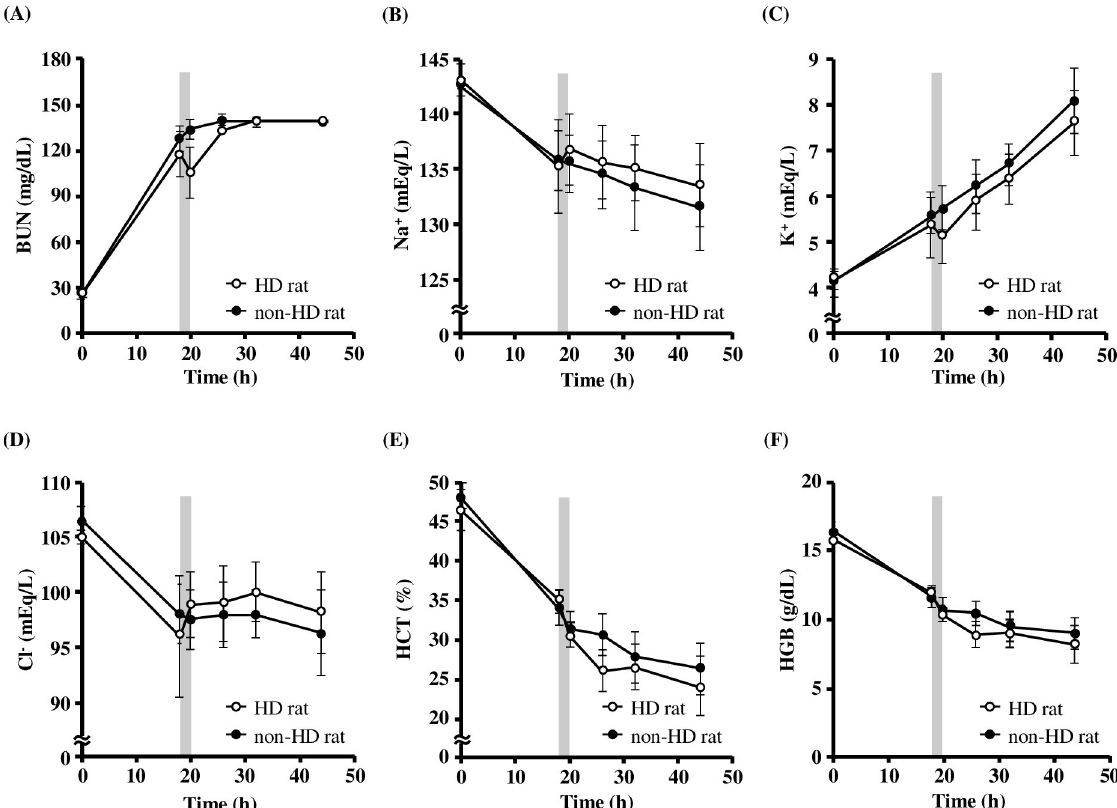
Fig 2. Physiological parameters of each rat with or without HD. The blood of each HD rat was corrected and BUN (A), Na + (B), K + (C), Cl - (D), Hct (E) and Hb (F) were measured. Hemodialysis timing was represented by the gray area. The value of BUN reached a plateau at 140 mg/dL, which is the measurement limit of the i-STAT 1 1 Analyzer. � : HD rat ( n = 4–7), ● : non-HD rat ( n = 3–4). Values are expressed as the mean ± SD. BUN: blood urea nitrogen, Na + : sodium, K + : potassium, Cl - : chloride, Hct: Hematocrit, Hb: Hemoglobin.